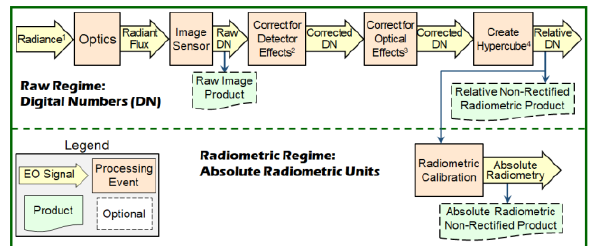
Figure 3 . Processing flow for the geoscience use